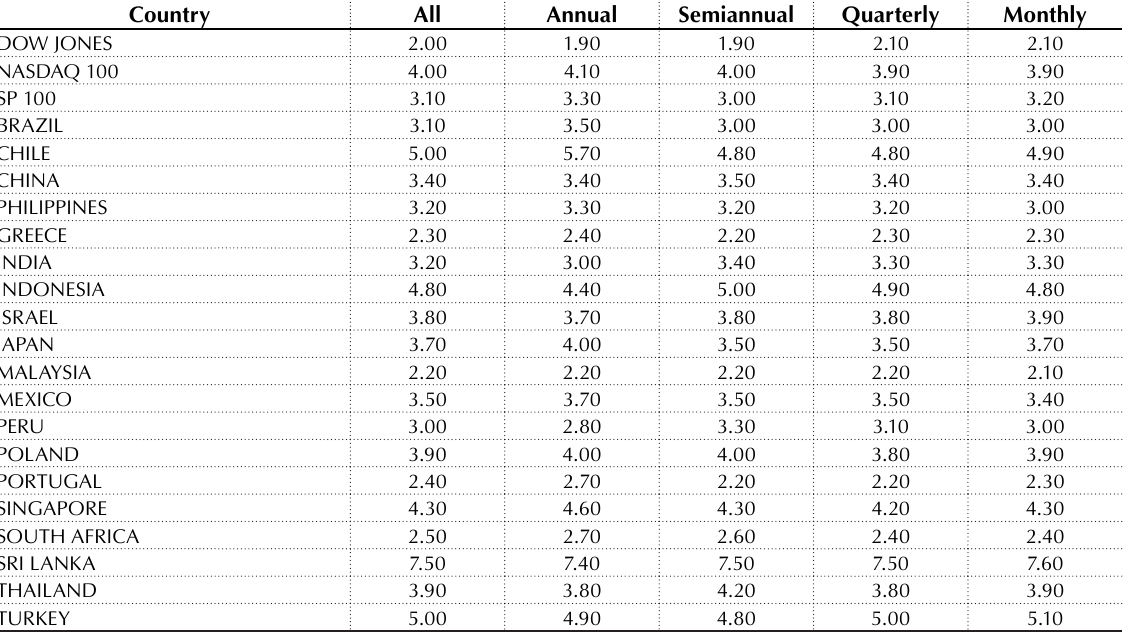
Table 4. Number of assets in portfolios